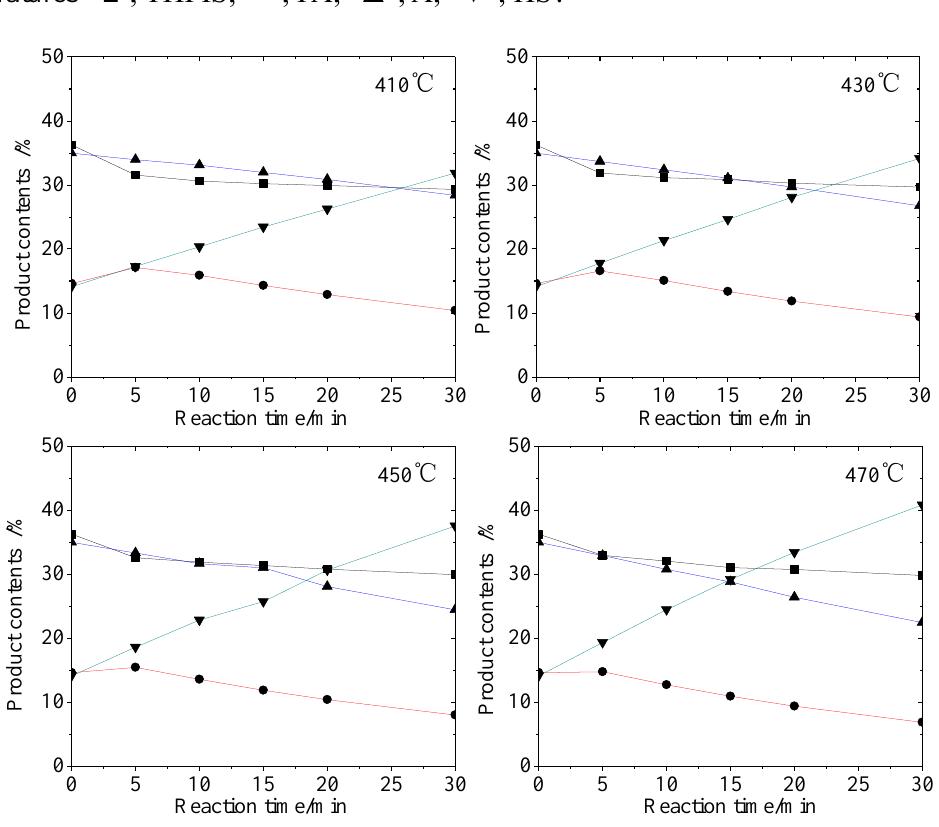
Figure 1. Product contents of Shenhua CHLR hydro-conversions vs. time at various temperatures ­■­, THFIS; ­●­, PA; ­▲­, A; ­▼­,